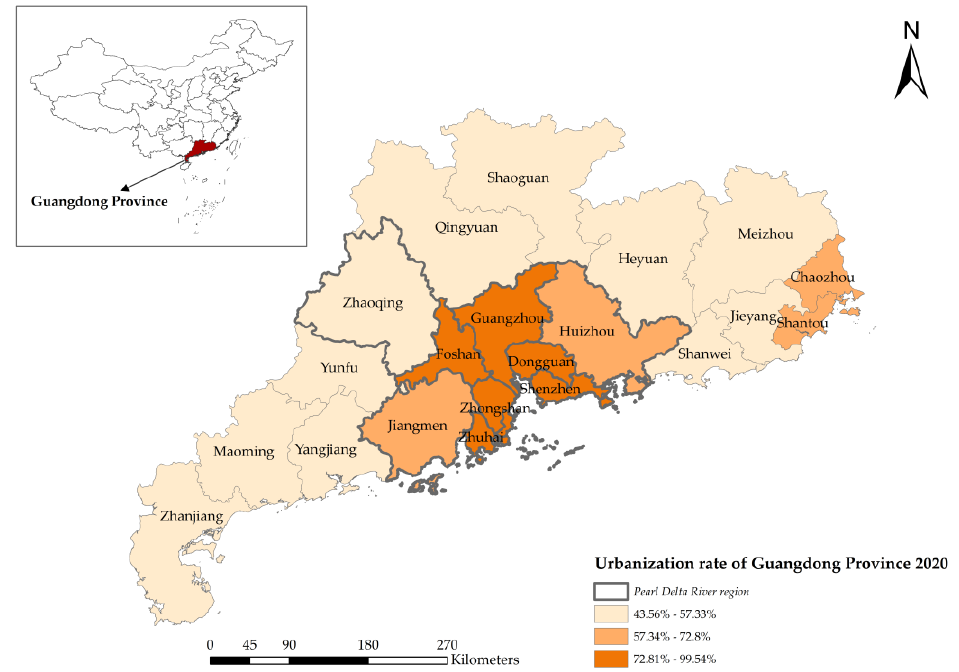
Figure 1. Study area.